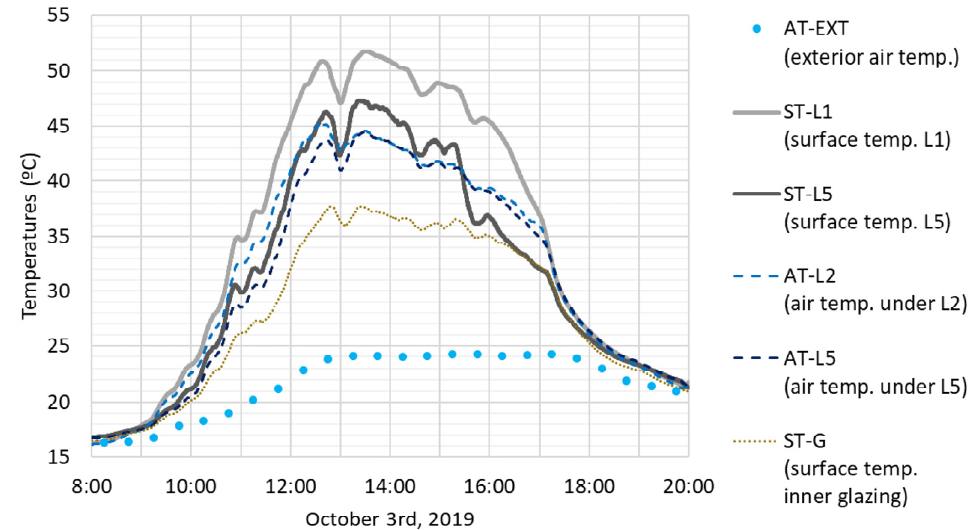
Figure 4. Temperatures in the model during the selected day in warm outdoor temperature condi- tions.